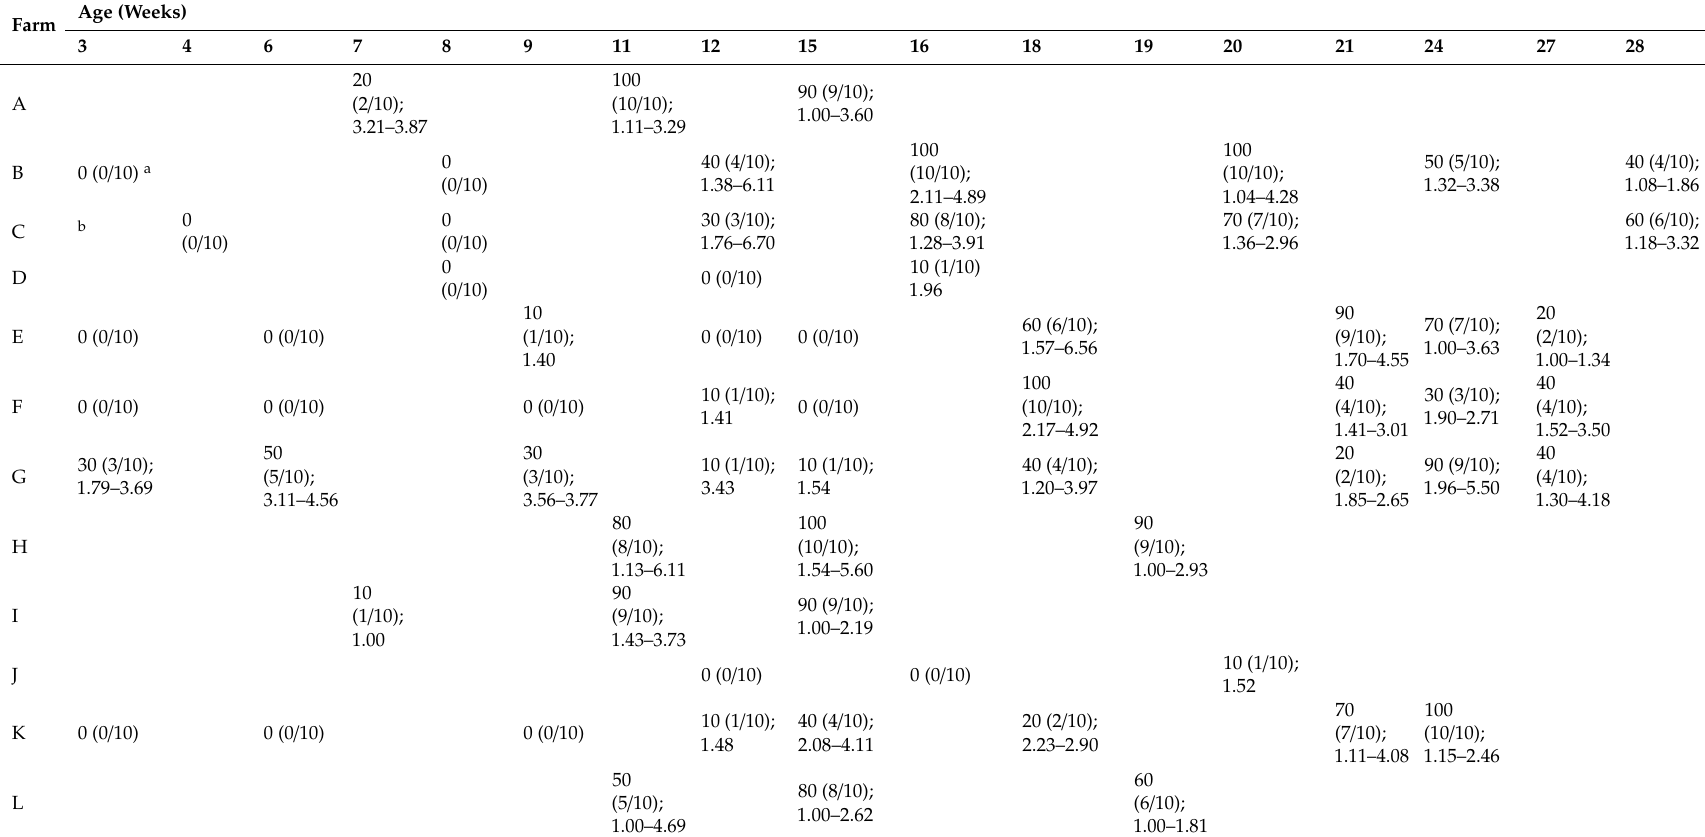
Table 2. Percentage of porcine circovirus type 2 (PCV2) detection and PCV2 loads in di ff erent aged